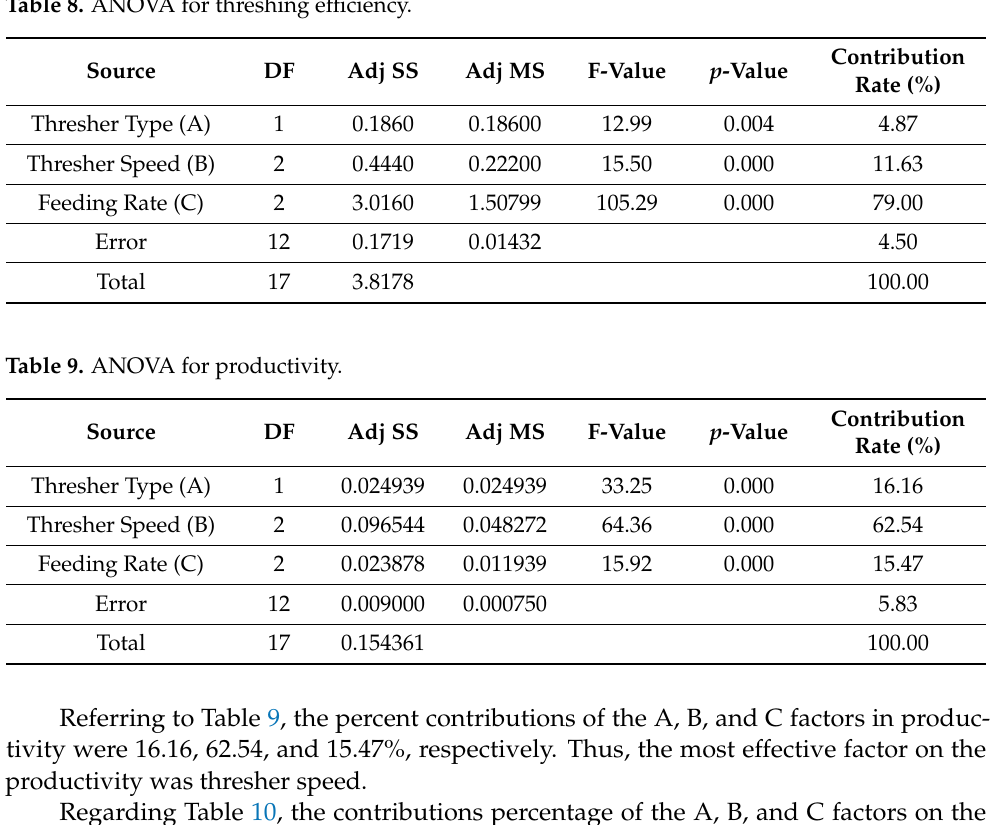
Table 8. ANOVA for threshing efficiency.